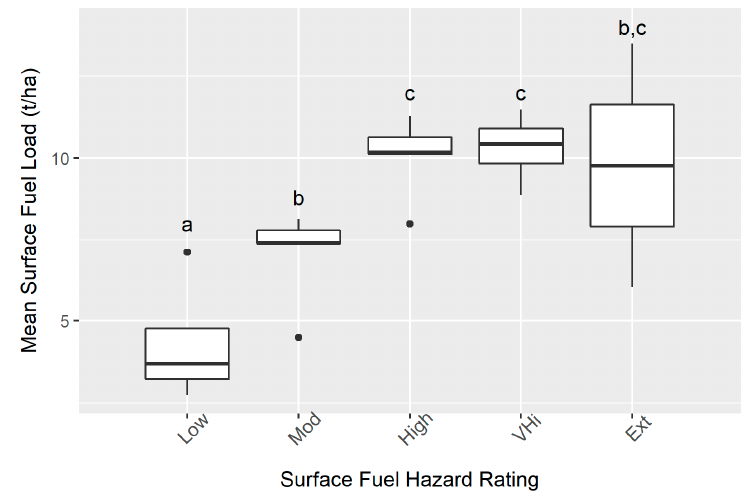
Figure 2. Destructively sampled surface fuel loads (t/ha) by fuel hazard rating. Box indicates the median (bold line) with lower and upper quartiles (25% and 75%). Whiskers indicate the minimum and maximum values that are not outliers (dots). Letters represent significantly different results.